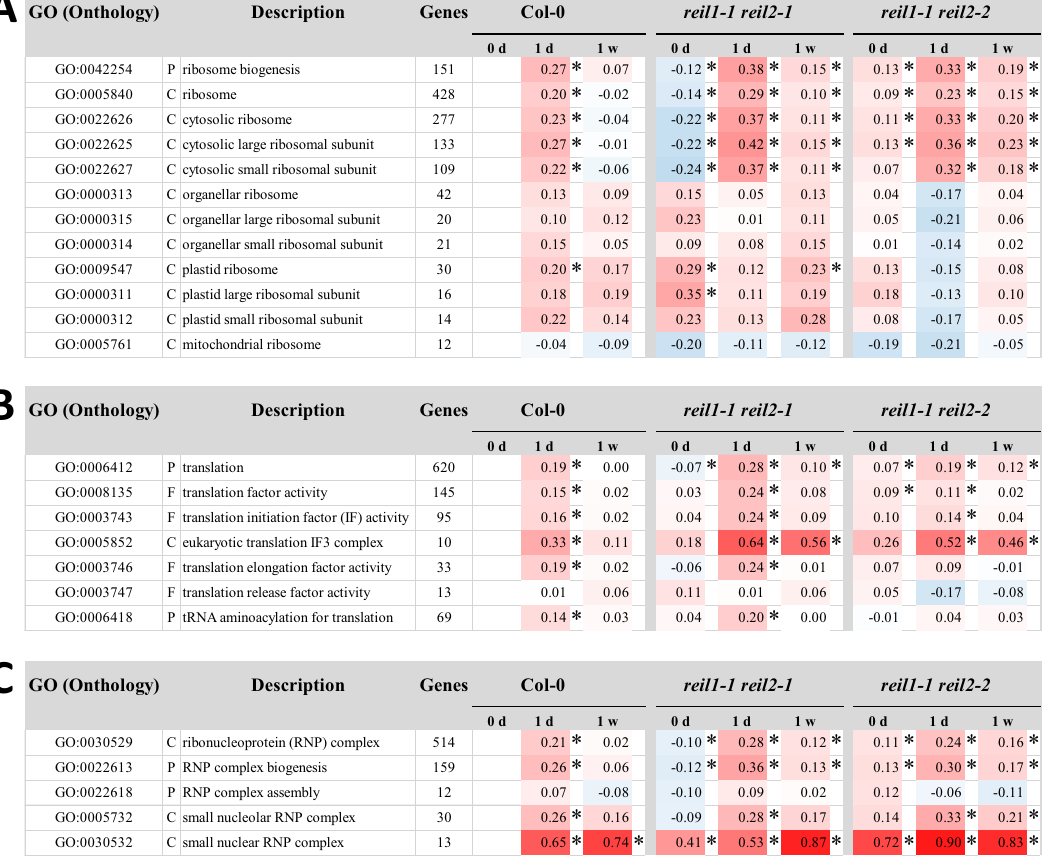
related genes responded in a pattern that was similar to cytosolic ribosomes (Supplemental Fig. S6B, Supple- mental Table S3). We added a more detailed study of RP gene expression from the 40S SSU (104 transcripts covered by our current study) and the 60S LSU (159 transcripts) complexes. We compared expression of cytosolic RPs to the plastid 30S (30 transcripts) and 50S (41 transcripts) RPs. This comparison revealed in part opposing effects of reil deficiency on structural cytosolic and plastid RPs (Fig. 7). At 10 °C, expression of 40S and 60S RPs coordi- nately increased in both mutants relative to Col-0 at each time point. In the non-acclimated state, reil1-1 reil2- 1 roots reduced cytosolic RP expression whereas reil1-1 reil2-2 roots had increased cytosolic RP transcripts (Fig. 7A). Expression of plastid RPs inversely increased in the non-acclimated state and decreased after shift to cold (Fig. 7A). Analysis of cytosolic RP transcripts by pairwise comparisons at each time point and by two factorial analyses of variance (ANOVA) that tested for the influence of the factors, mutant genotype and time of cold exposure, indicated heterogeneity of RP gene expression changes at single gene levels (Fig. 7B, Supplemental Table S2). Many RP gene families comprised members that were either significantly affected by the factor cold or the genotype. We also observed RP paralogs with significant interactions between genotype and cold exposure or without significant changes (Fig. 7B). In summary, reil deficiency globally activates cytosolic RP expression in roots with inverse effects on plas- tid RP gene expression. Reil deficiency can affect gene expression of paralogs from one family synergistically, e.g. RPL4A and RPL4D (Fig. 7B). Alternately, gene expression of RP paralogs from 40 and 60S RP families can respond differentially, for example paralogs of the RPL3 , RPP2 or RPP3 , and of the RPS23 , and RPS27 gene